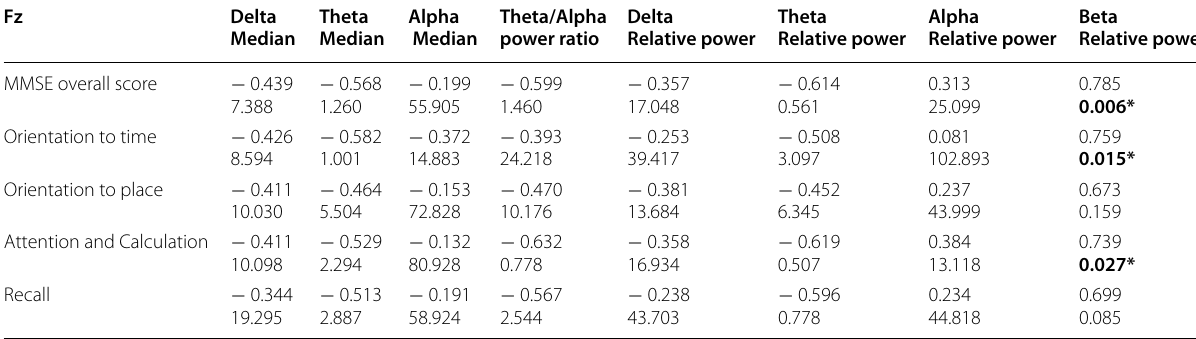
Table 4 Correlations between MMSE scores and markers recorded from Fz